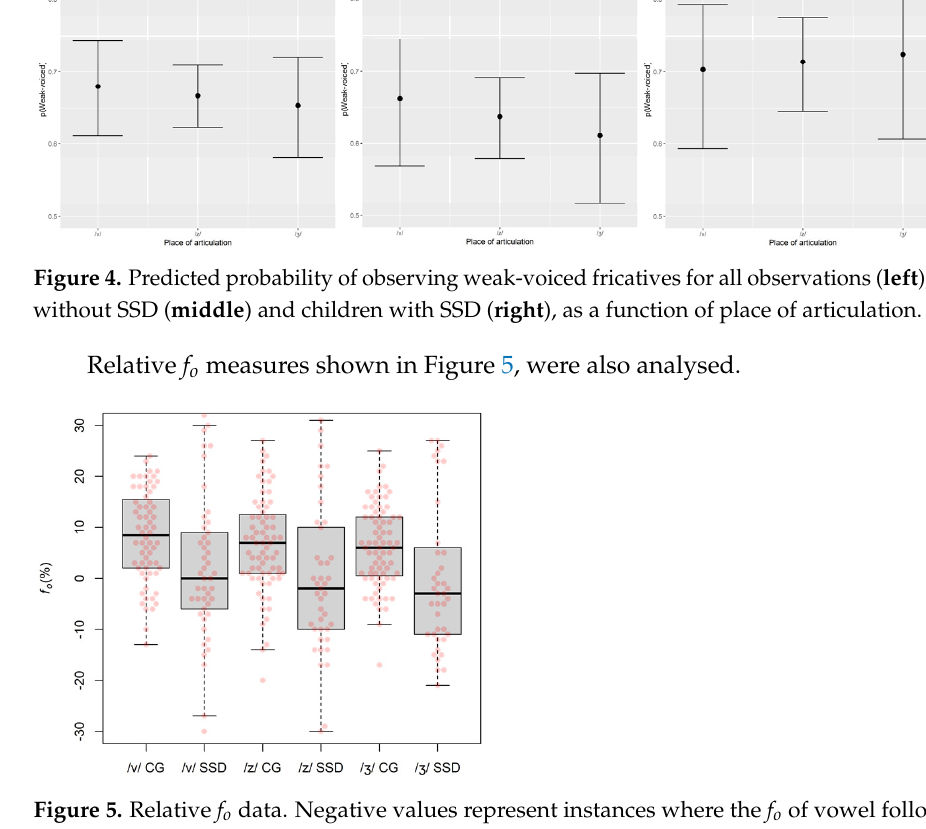
Figure 5. Relative f o data. Negative values represent instances where the f o of vowel following the fricative was lower than during the actual fricative production.